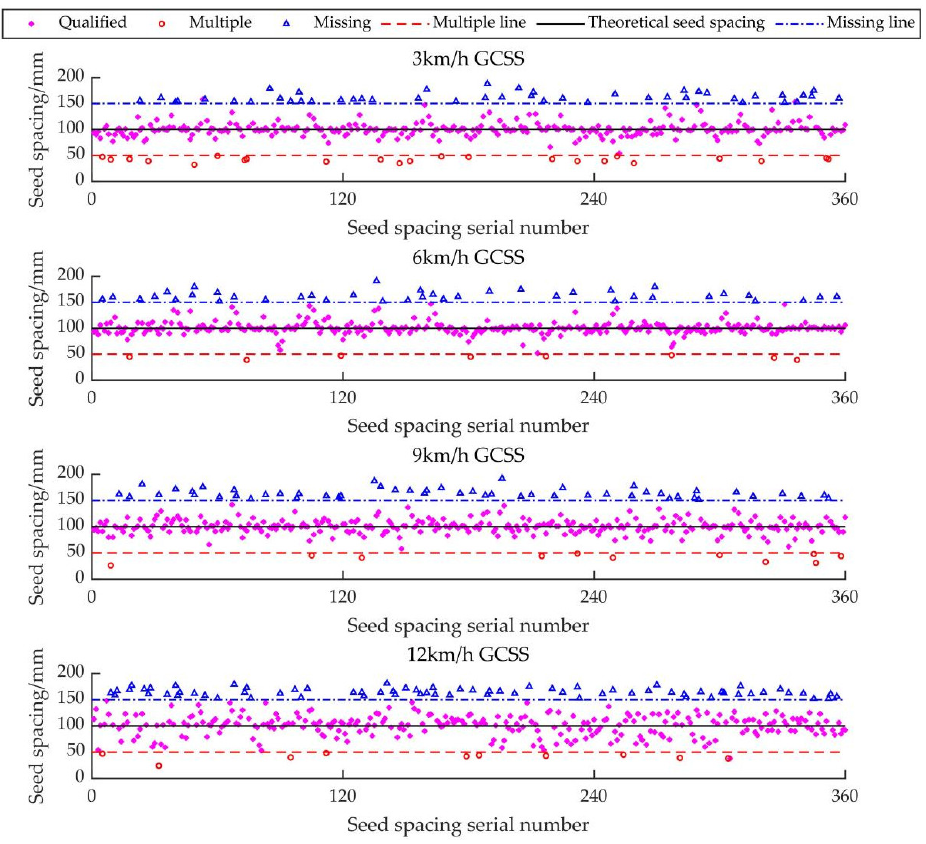
Figure 11. The distance distribution of GCSS under each index.